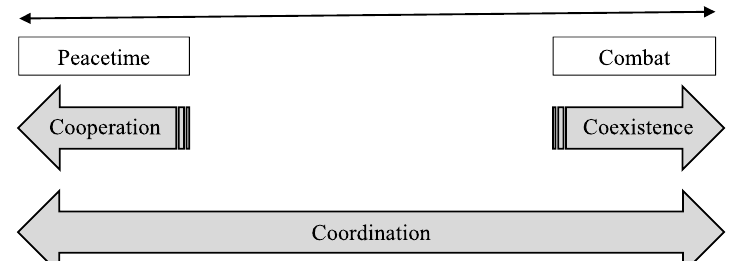
Fig. 1 This figure is adapted from Metcalfe, Haysom, and Gordon